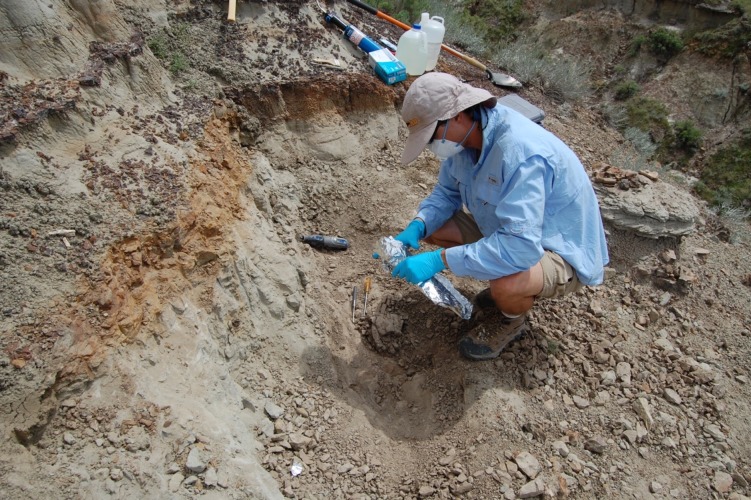
Aseptic collection of fossil samples in BB180 on July 8, 2016.Only skin of the face, wrists, and shins was exposed above the fossils. Shins remained uncovered to act as a thermal window for health and safety reasons to avoid overheating and to reduce the likelihood of contamination by lowering body temperature to reduce perspiration that might fall onto the samples. The body was positioned downhill of the bones at all times to compensate. Photograph by Kentaro Chiba.